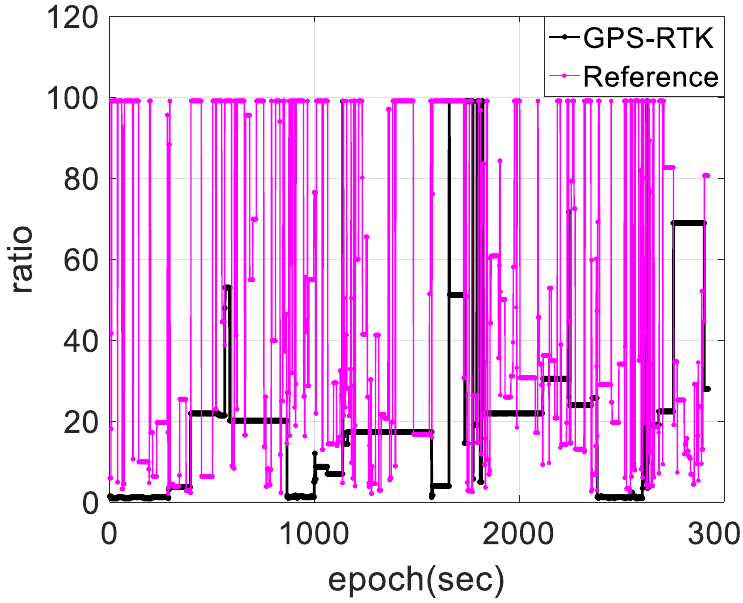
Figure 6. Ratio comparison between the referenced and GPS-RTK.